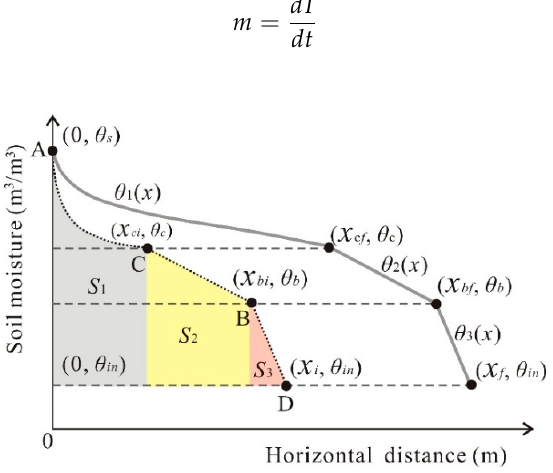
( ) x θ is soil moisture 3